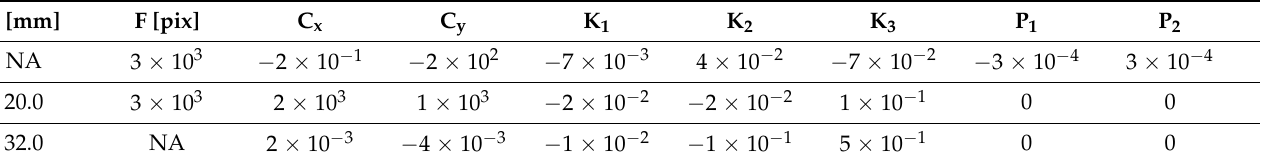
Table 10. Automatic camera calibration for the truck in the controlled environment using Agisoft, Pix4d, and RealityCapture, respectively.